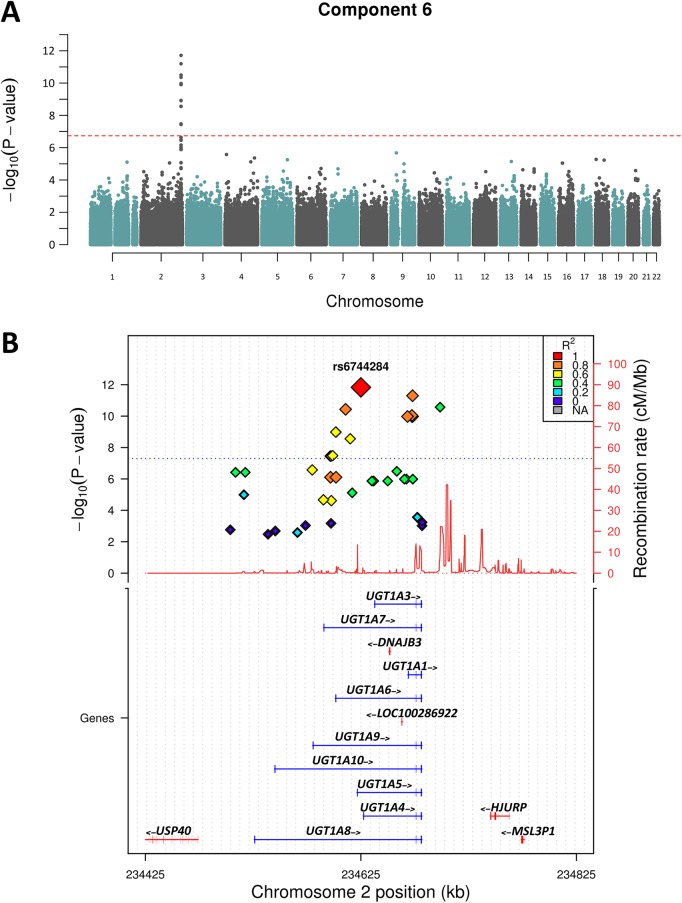
Manhattan plot of Chromosome 2 showing Component 6 associations.A) shows the genome-wide associations statistics with a distinct peak on chromosome 2 for bilirubin, B) refines the location of the peak to chr2q37.1, a region containing the UDP-glucuronosyltransferase gene family well known to metabolise bilirubin (UCSC track demonstrates the numerous isoforms). The blue dotted line indicates genome-wide significance level.